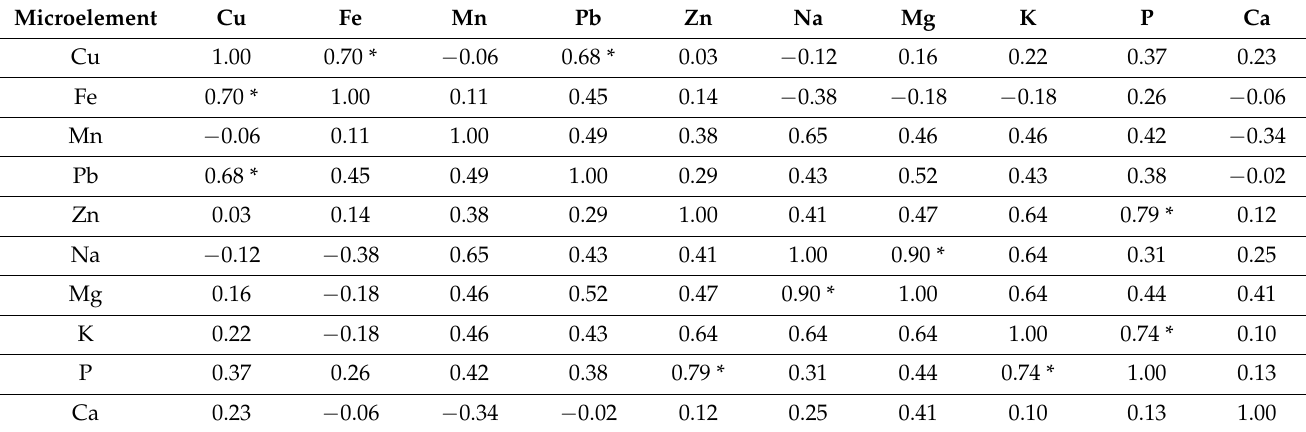
Table 9. Correlations between the individual concentrations of elements in healthy intervertebral